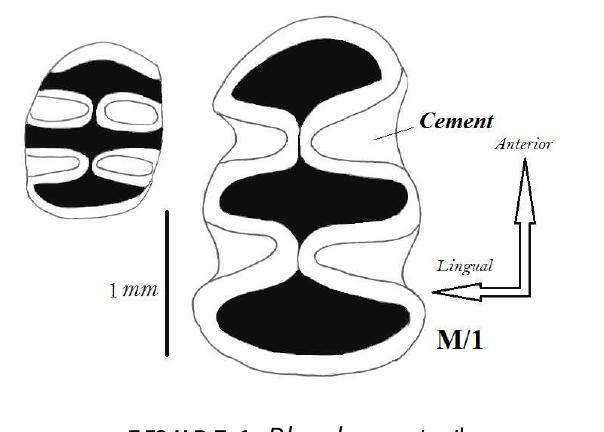
FIGURE 1 : Rhombomys